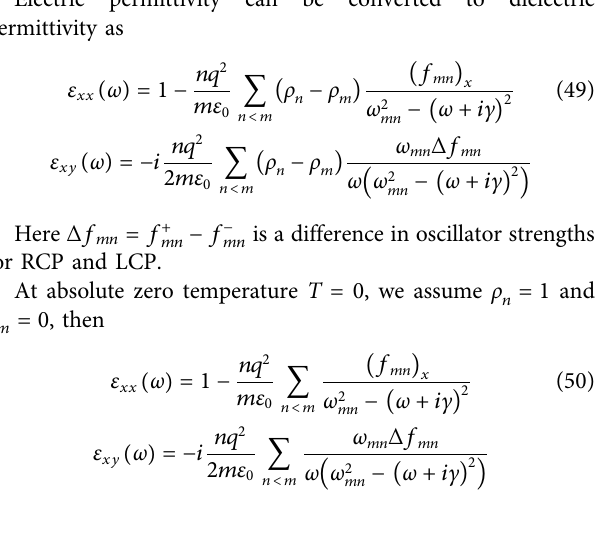
Frontiers in Physics |